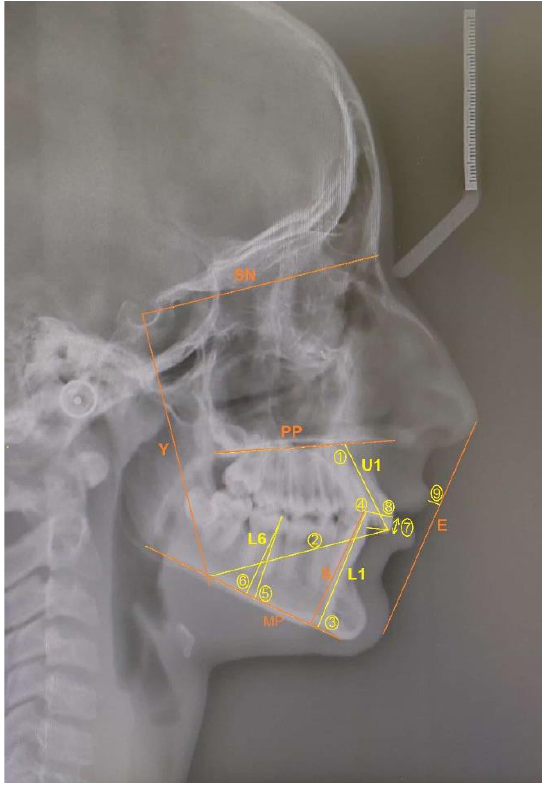
Figure 2. The angular and linear dentoalveolar measurements. Legends: 1: U1/PP (°) is the angle formed between the maxillary central incisor (U1) long axis and the palatal plane (PP) and indicates maxillary incisor inclination; 2: U1/Y axis (mm) is the distance between the incisal edge of maxillary central incisor perpendic- ular to the Y axis (formed by dropping a line from the sella perpendicular to the SN line) indicates horizontal maxillary incisor distance; 3: L1/MP (°) is the angle formed between the mandibular central incisor (L1) long axis and the mandible plane (MP) and indicates mandibular incisor inclination; 4: L1/S axis (mm) is the distance between the incisal edge of the mandibular central incisor perpendicular to the S axis (formed by dropping a line through the posterior conture of symphysis perpendicular to the MP line) and indicates horizontal mandibular incisor distance to S axis; 5: L6/MP (°) is the angle between the mandibular first molar (L6) long axis (line passing through the mesial cusp tip and the mesial root tip) and the mandibular plane, and indicates mandibular first molar inclina- tion; 6: L6/MP (mm) is the distance between the mesial cusp tip of the mandibular first molar perpendicular to the mandibular plane and indicates vertical mandibular first mo- lar distance; 7: overjet is the horizontal distance from the maxillary incisor tip to the labial surface of the mandibular incisor; 8: overbite is the vertical distance from the mandibular incisor tip to the maxillary incisor tip; 9: U1/E line is the horizontal distance from the labial surface of the maxillary incisor perpendicular to the E line The fixed sagittal guidance (FSG) appliance is a fixed orthodontic appliance bonded on both upper molars, manufactured of a crown (cobalt-chromium alloy) and the occlusal inclined plane of SR Chromasit material (pressure/heat-curing micro filled veneer mate- rial) (Figure 3). Crowns (Figure 4) were produced using a scanner (to import physical data about the teeth into the computer) and 3D computer design and a specific method of se- lective laser melting (SLM) (MLab, Concept Laser, Treatstock, Newark, DE, USA) manu- facturing technology (adding a layer on top of the layer) [5]. Special small hooks were added to the crowns for bondage and safety of the appliance (Figure 4). The inclination was oriented individually to the occlusal plane (angle), thereby actively guiding the